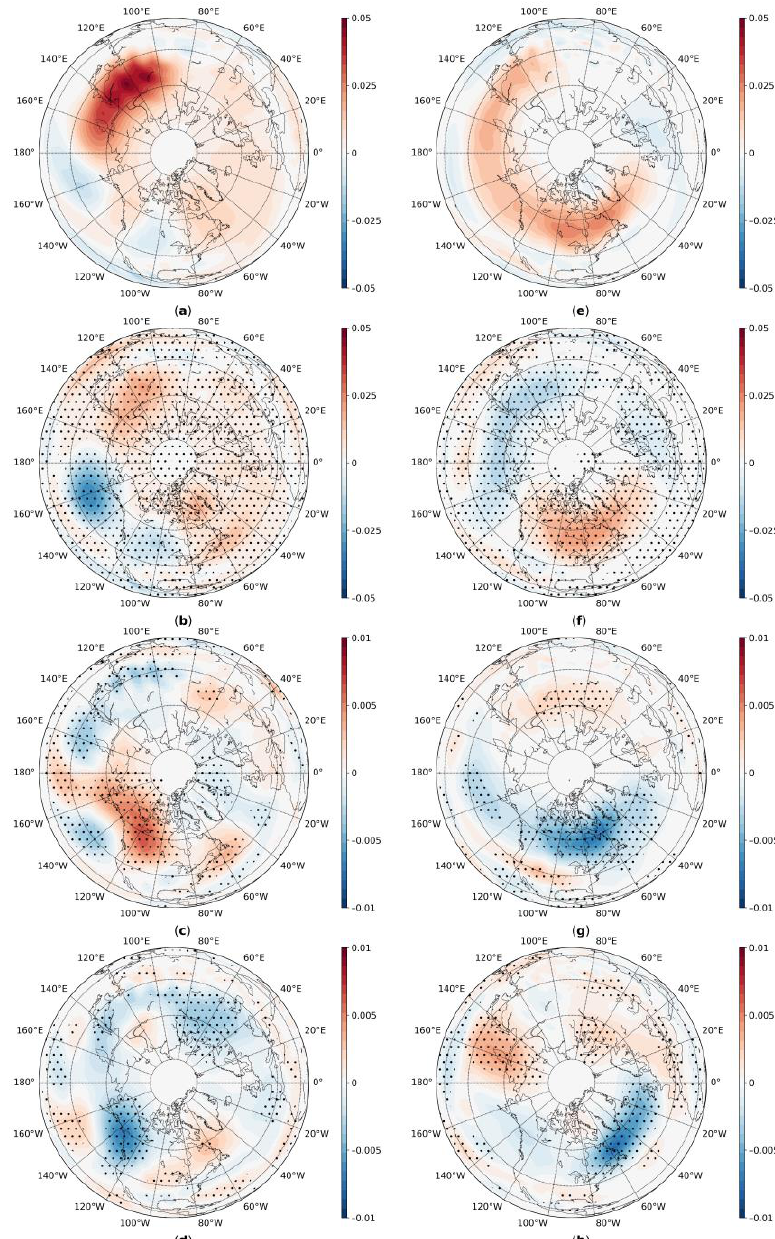
Figure 7. The vertical component of the Plumb flux (Fz) at the 100 hPa level in EN ( a ) and LN ( e ) experiments, and their differences from the Fz in the CTRL experiment ( b , f ), respectively. Statistically significant differences of the mean values at the 5% level ( b , f ) are marked with dots. The differences between the Fz in the EN&PDO+ ( c ), EN&PDO − ( d ), LN&PDO+ ( g ), and LN&PDO − ( h ) and the corresponding “ single ” ENSO experiments.